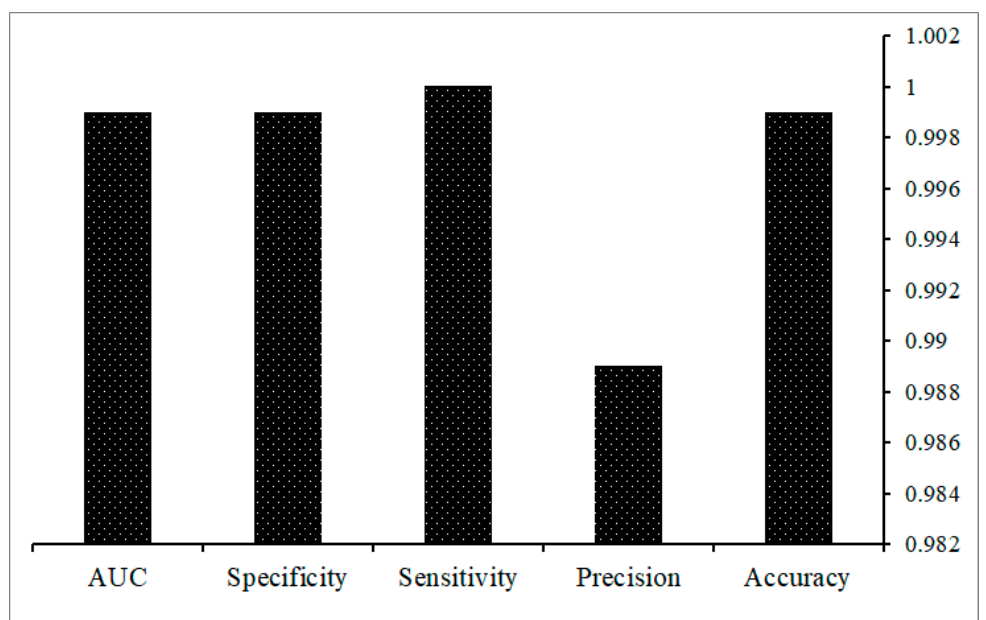
Figure 6. Performance parameters of ANN models for 6-group essential oils classification.